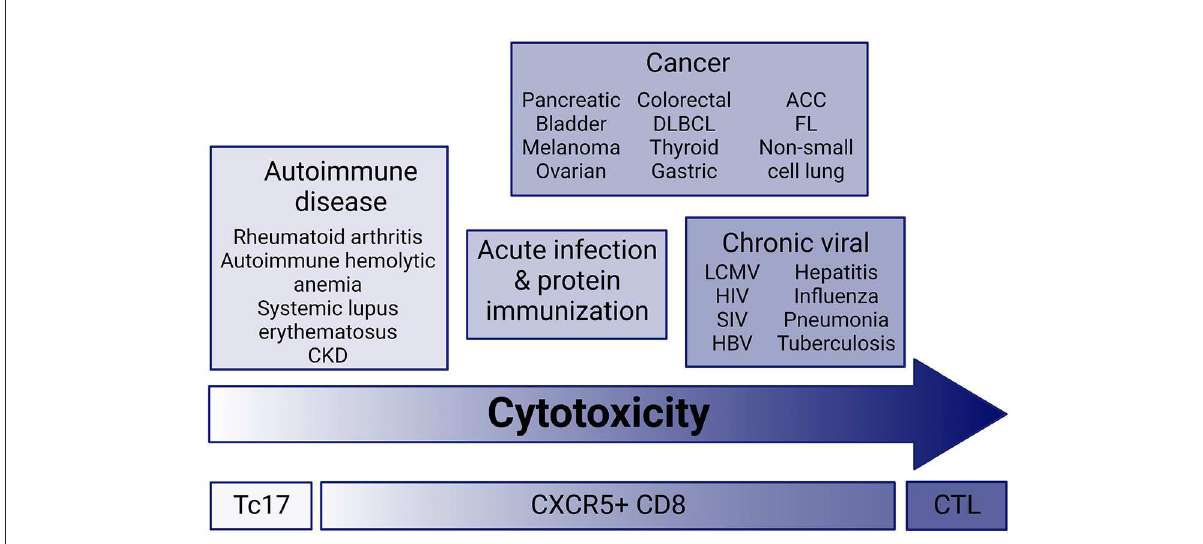
FIGURE1 Cytotoxic potential across disease. CXCR5 + CD8T cells have a range of cytolytic potential in infection, cancer, and autoimmune disease. Current research suggests that cytolytic and effector molecule expression ranges from very low in autoimmune disease similar to Tc17 effector cells, and high in chronic infection and cancer. CXCR5 + CD8T cells from acute infection and immunization with protein maintain an intermediate cytolytic potential. CKD, chronic kidney disease; ACC, Adenoid cystic carcinoma; FL, follicular lymphoma; DLBCL, diffuse large B cell lymphoma; CTL, cytotoxic T lymphocyte; Tc17, IL-17-secreting CD8T